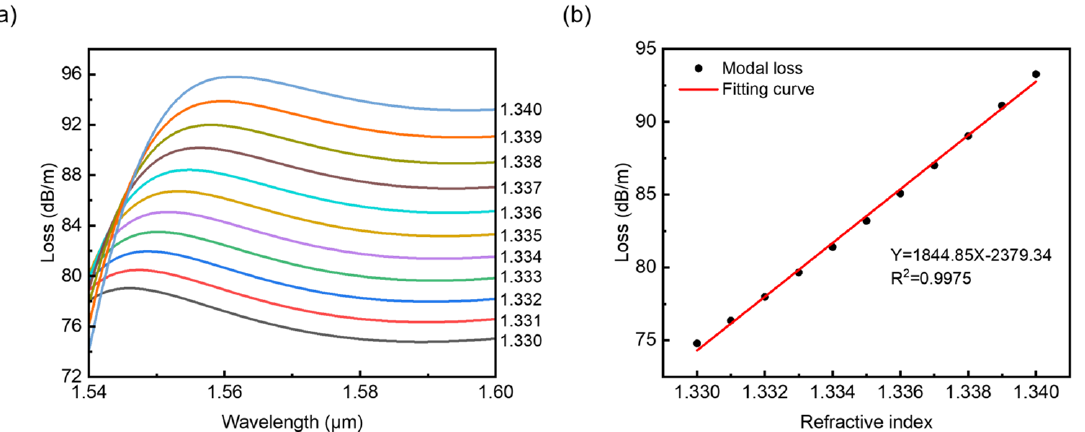
Figure 8. ( a ) Confinement loss versus wavelength with analyte refractive index changing from 1.33 to 1.34 for A =12.1 cm − 1 . ( b ) Linear fitting for selected wavelength λ = 1.589 μ m.